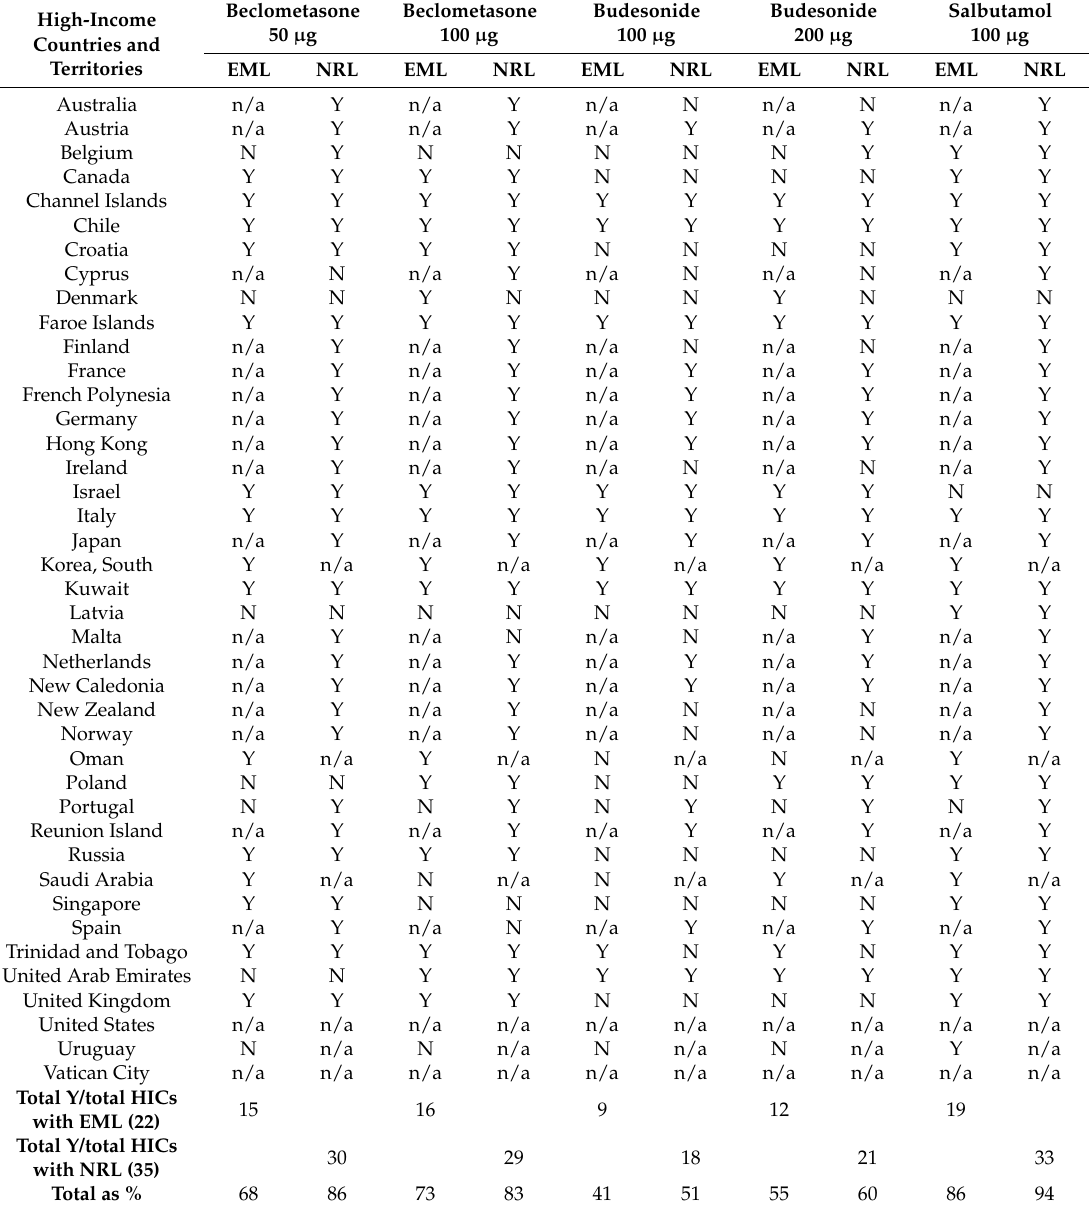
Table 3. Inclusion of HFA inhalers from the WHO Essential Medicines List in National Essential Medicine and National Reimbursement Lists in 41 high-income countries and territories, 2014 *. High-Income Countries